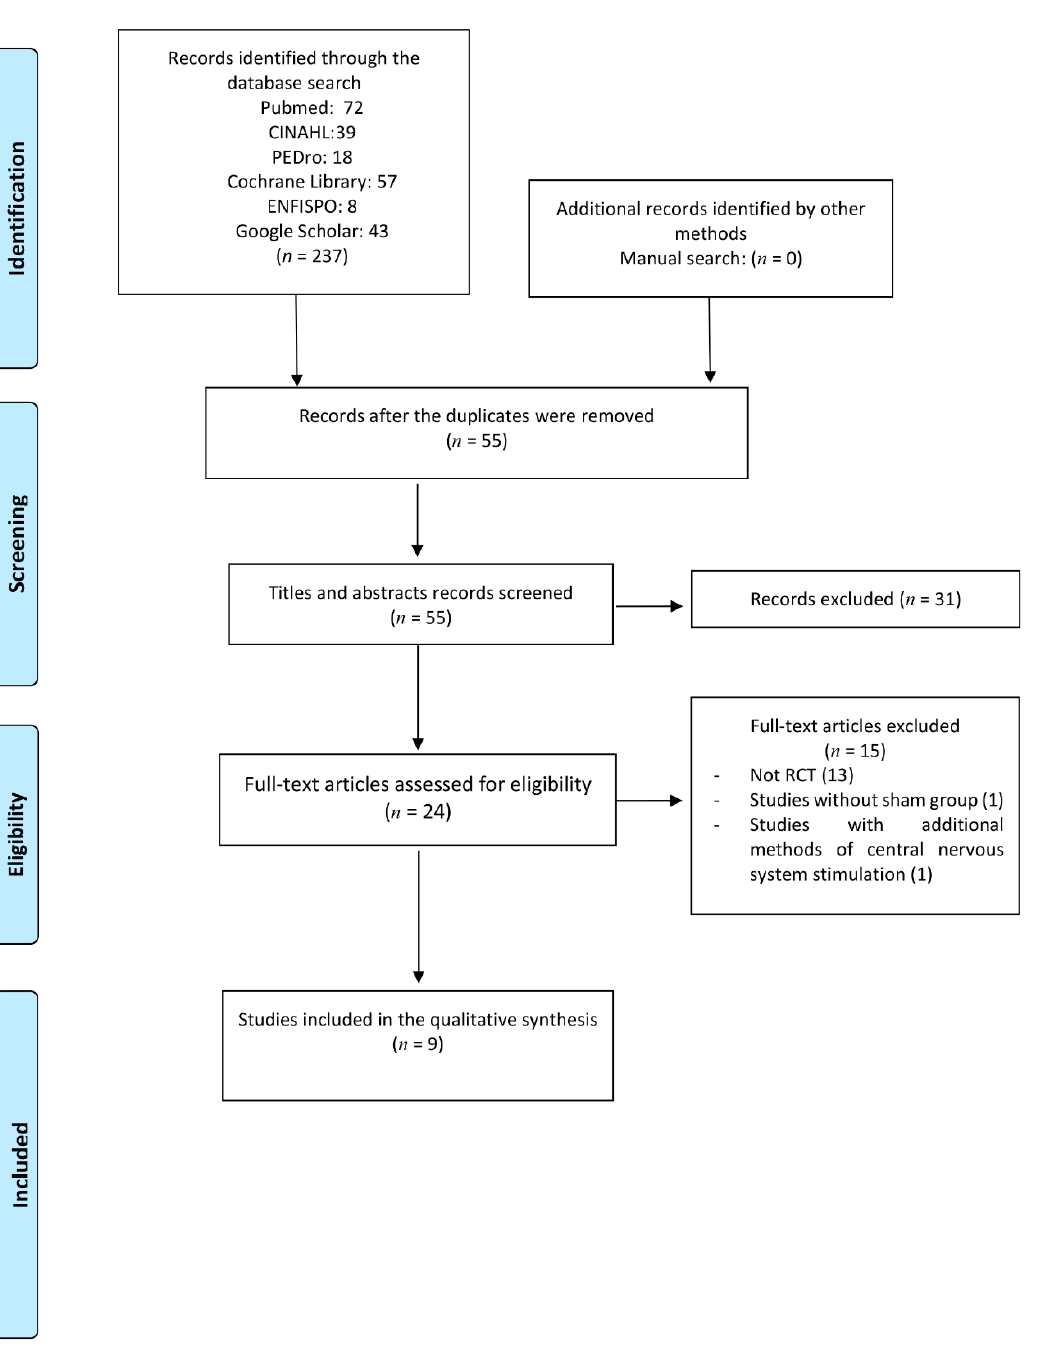
Figure 1. Flow diagram of the systematic review process, including the identification, screening and eligibility steps, recommended by the guidelines included in the Preferred Reporting Items for Systematic Reviews and Meta-Analyses (PRISMA).